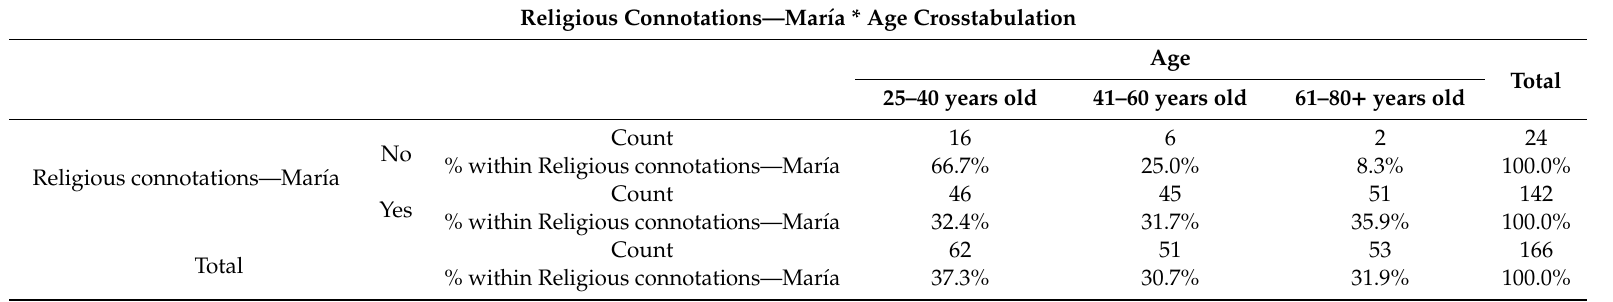
Table 2. Religious connotations in terms of age for the name Mar í a in the metropolitan district of Murcia.